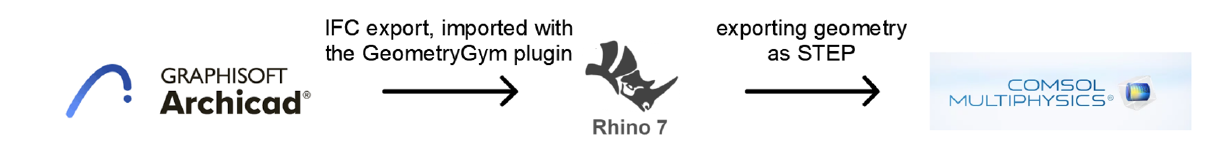
Figure 2. Open BIM workflow based on